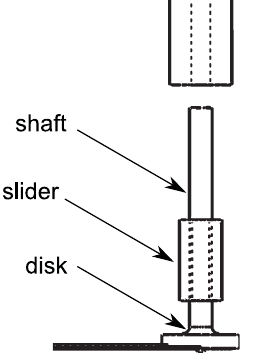
Fig. 7. Structure of the